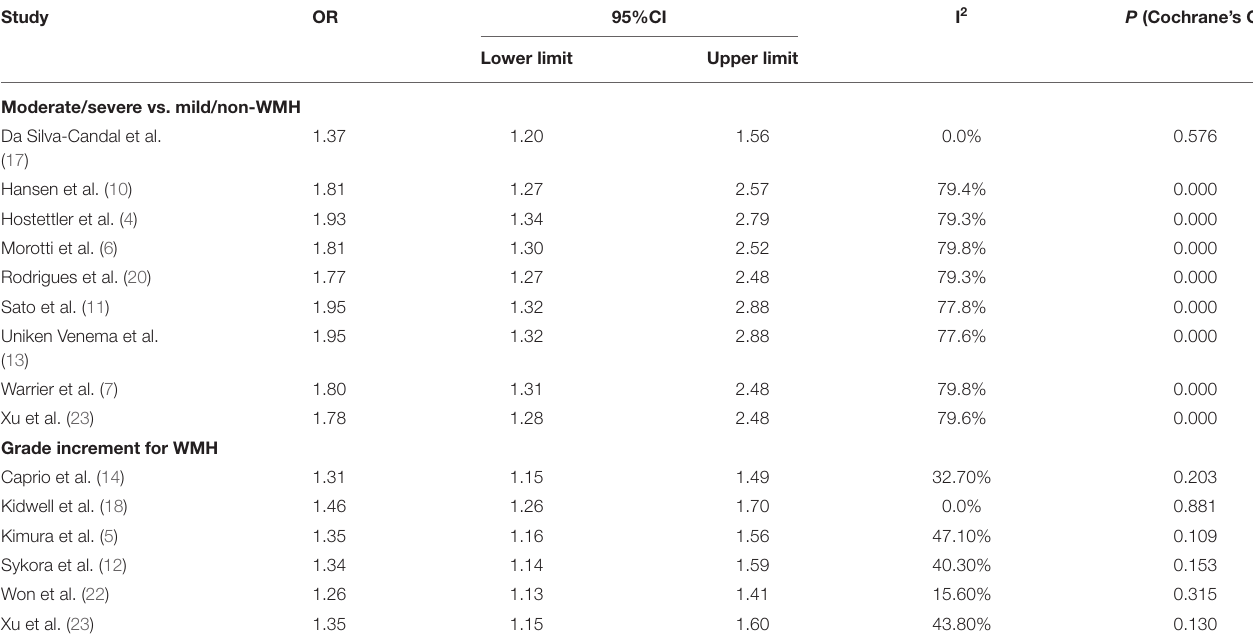
TABLE 2 | Sensitivity analysis of WMH and functional outcomes.